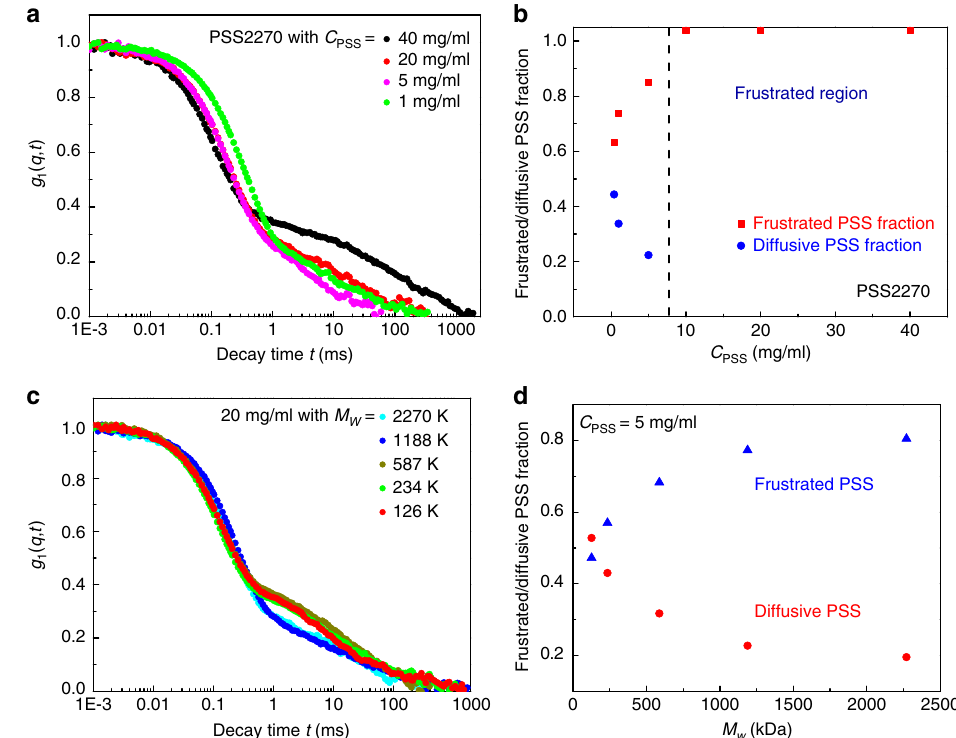
Fig. 6 Dynamical transition of PSS in gel matrix with different M w and C . a , c Normalized fi eld-correlation function g 1 ( q , t ) at scattering angle 30° of PSS in the gel matrix with 0.1 M NaCl for ( a ) PSS2270 with different PSS concentrations; ( c ) PSS with different M w at the same PSS concentration C = 20 mg/mL. b Fractions of frustrated and diffusive PSS chains for PSS2270 at different PSS concentrations. The dashed line denotes the crossover from totally frustrated dynamics to part of PSS being diffusive. d Fractions of frustrated and diffusive PSS chains for PSS with different molar masses at the same PSS concentration 5 mg/mL. The fraction of frustrated and diffusive PSS comes from (1 − a 1 − a 2 )/(1 − a 1 ) and a 2 /(1 − a 1 − a 2 ), respectively, in Eq.